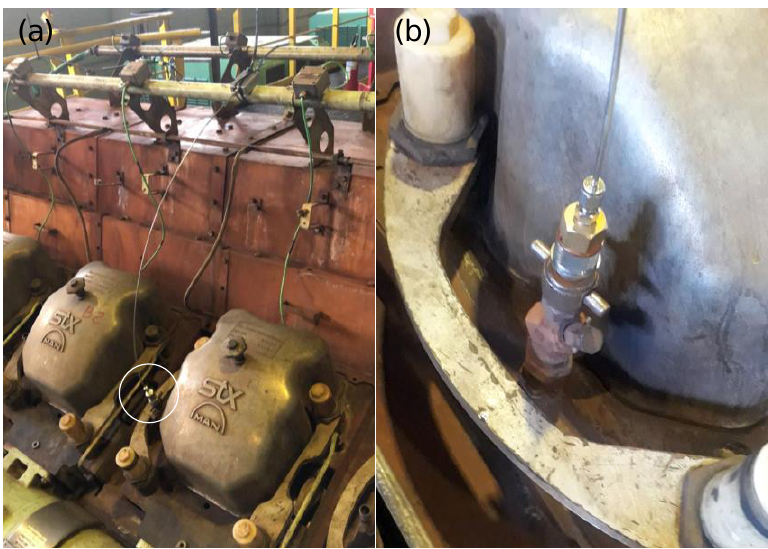
Figure 12. ( a , b ) Sensor sealed with polymer in the engine pressure monitoring point.